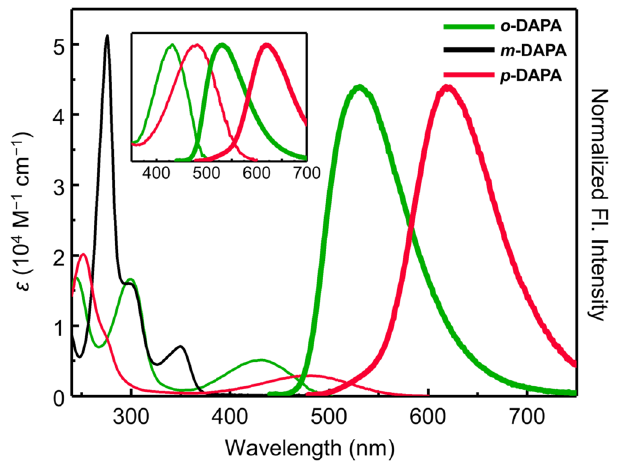
Fig. 3 Structure-dependent light absorption and emission. Absorption (thin lines) and normalized emission (thick lines) spectra of o -DAPA (green), m -DAPA (black), and p -DAPA (red) in CHCl 3 (sample concentrations = 50 μ M). The inset compares the absorption (thin lines) and emission (thick lines) spectra of o - and p -DAPA; the absorption spectra are normalized to the absorbance at the longest maximum absorption wavelengths ( λ max,abs ), whereas the emission spectra are normalized to the maximum fl uorescence intensity. Fl., fl